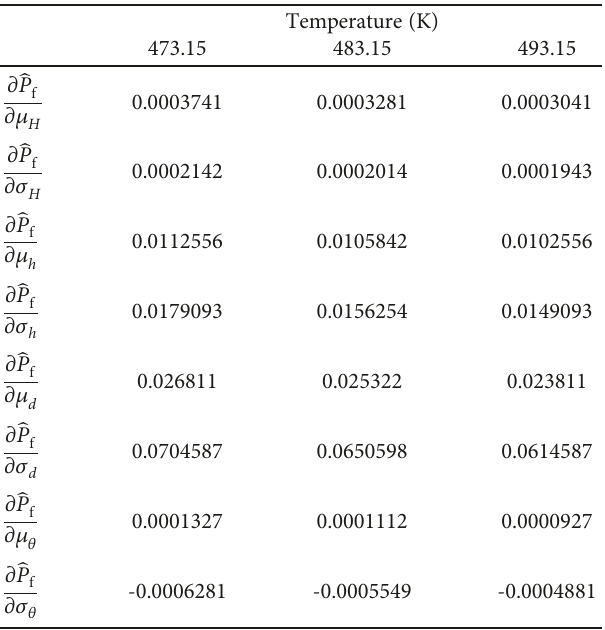
optimal functionality, improving aircraft safety and perfor- mance in icy conditions.